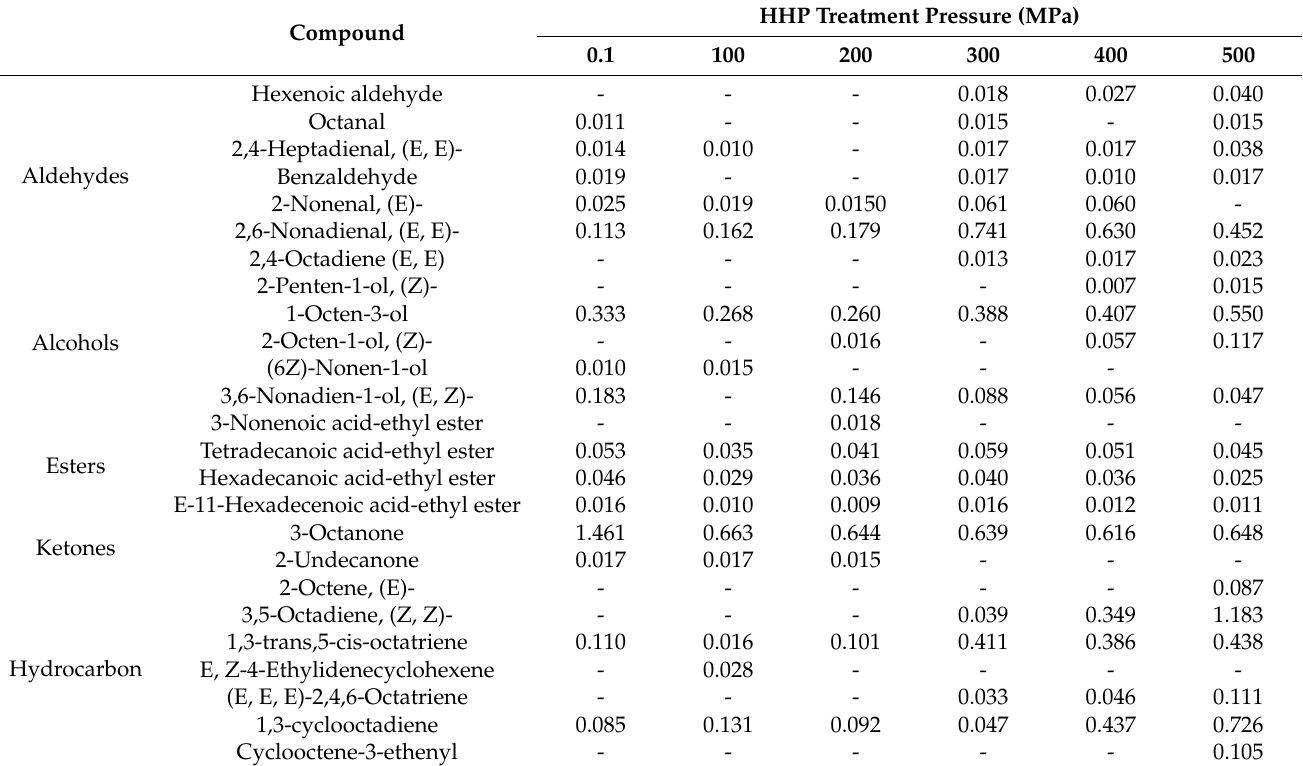
Figure 1. Principal component analysis of electronic nose ( a ) and flavor radar map ( b ). Table 4. Volatile compounds identified by SPME/GC–MS in oysters after HHP